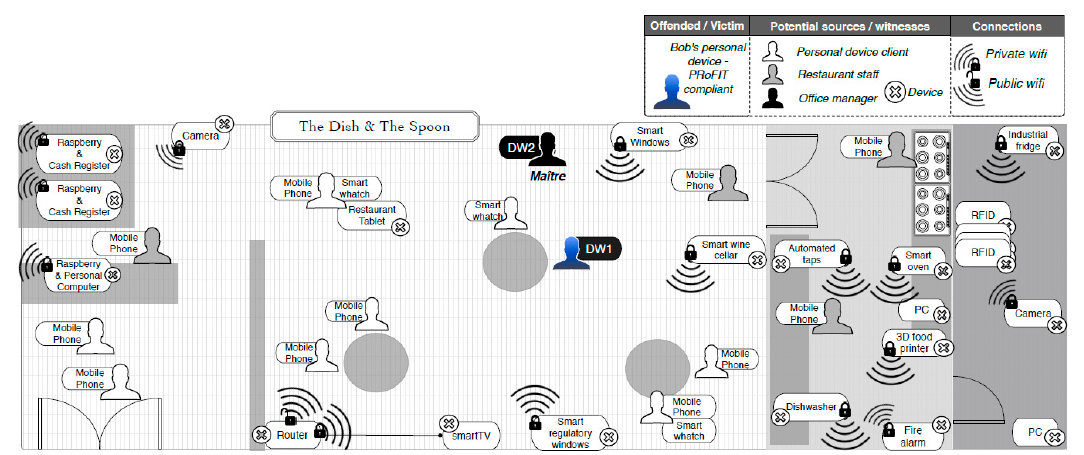
Figure 6. Use case 1: The Dish and The Spoon.